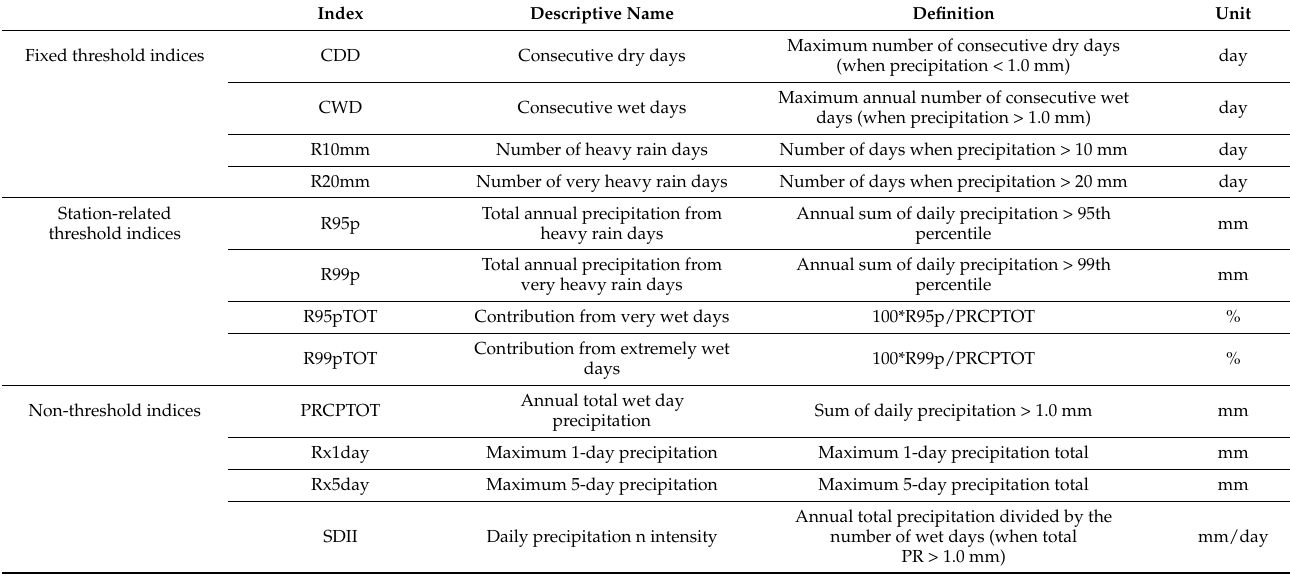
Table 2. Precipitation indices used in this study.